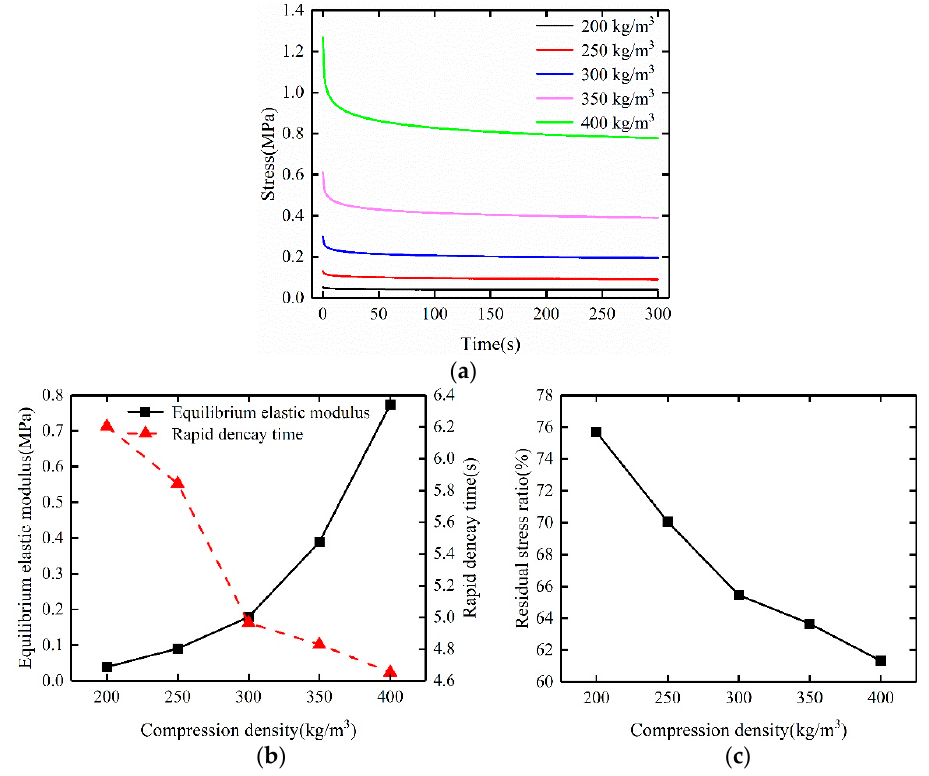
Figure 6. Stress relaxation characteristics at different compression densities: ( a ) Stress relaxation curve; ( b ) Equilibrium elastic modulus E e and rapid decay time T 1 , ( c ) Residual stress ratio ε .